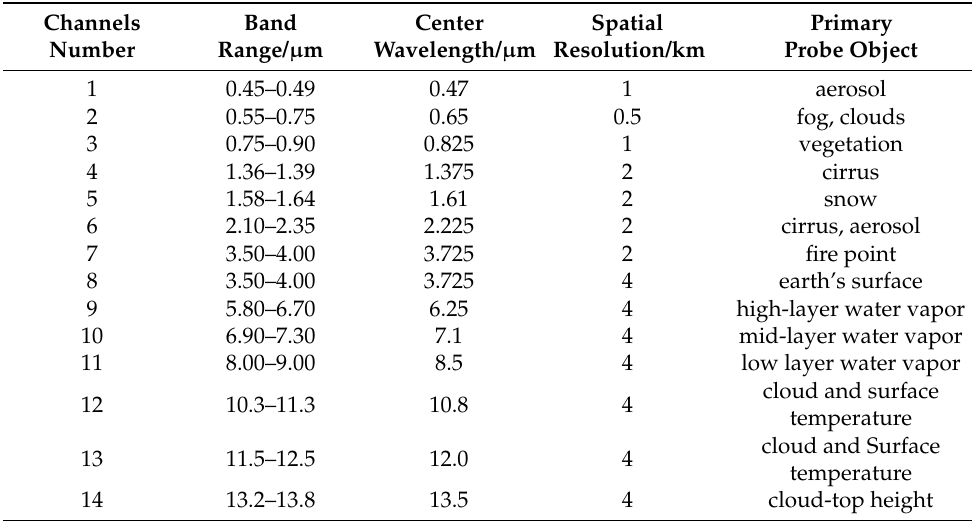
Table 1. The setting of FY-4A/AGRI spectral band and main detection